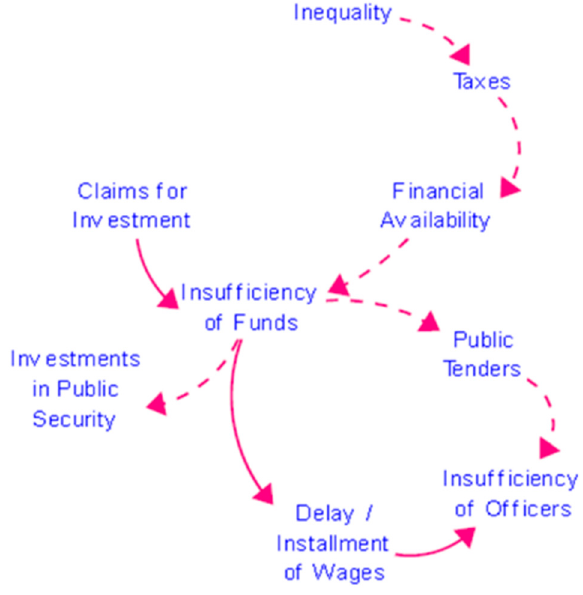
Figure 4. First partial scheme of the CLD of GQ3.